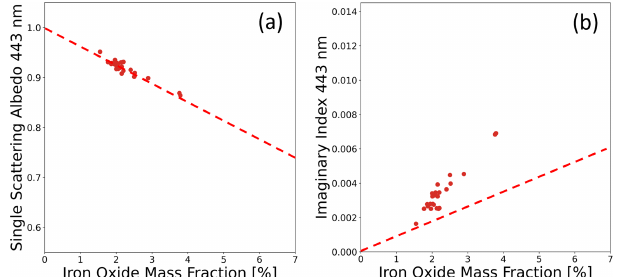
Figure 7. Relationship between the iron-oxide mass fraction (wt%; x axis) and SSA 443nm ( y axis, a ) and the imaginary refractive index ( y axis, b ). Red points represent the mean values of the 24 cases described in Sect. 3.1. The dashed line shows the estimated relationship at 443nm from Di Biagio et al.